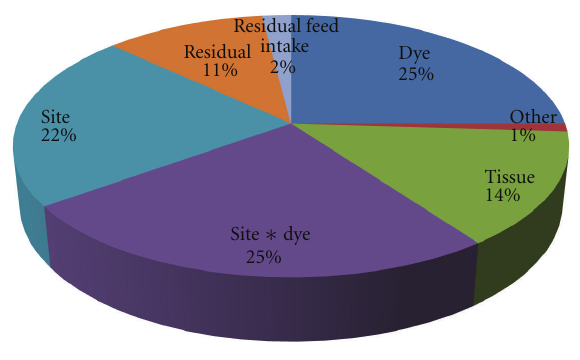
Figure 7: Sources of variability in Principal Components 1 through 3 (30.79% of Total Variance) in a 36 slide microarray experiment replicated at two locations. The majority of variation is due to dye and site e ff ects, which can be controlled for during the data analysis. Tissue and residual feed intake (an experimental condition not analyzed for this paper) contribute measurable amounts of variation to expression levels enabling detection of di ff erential expression.